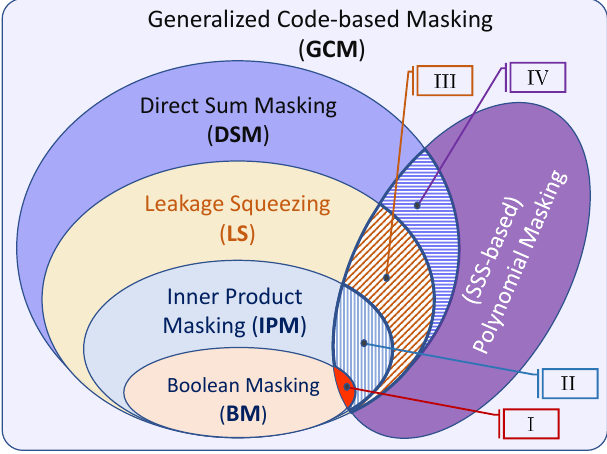
Figure 1: Overview of code-based masking schemes. In particular, all intersections I, II, III, and IV mean that n = t + 1 in SSS-based masking, where the two codes C and D are